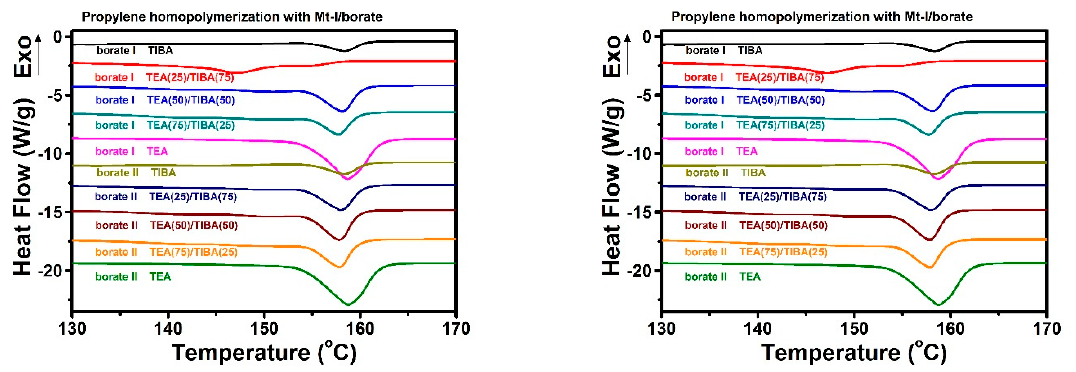
Figure 8. DSC heating traces of PP produced with Mt/borate under TEA/TIBA mixtures of different ratios.